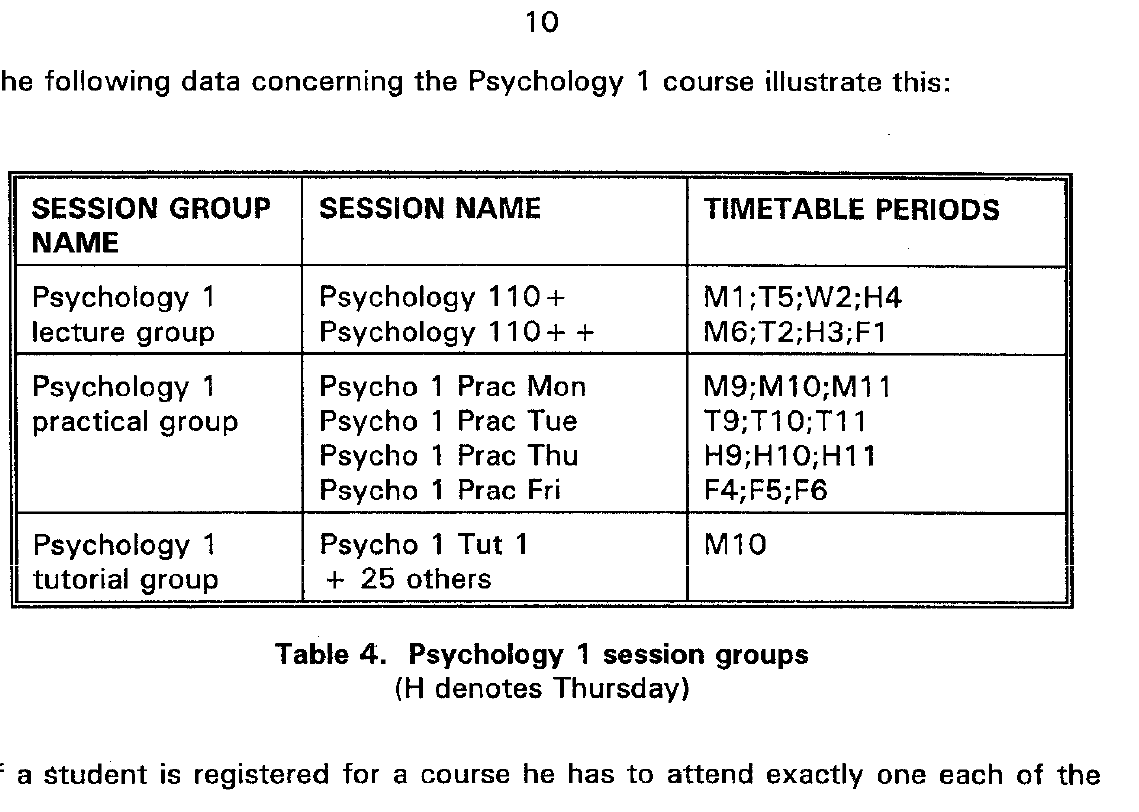
Table 4. Psychology 1 session